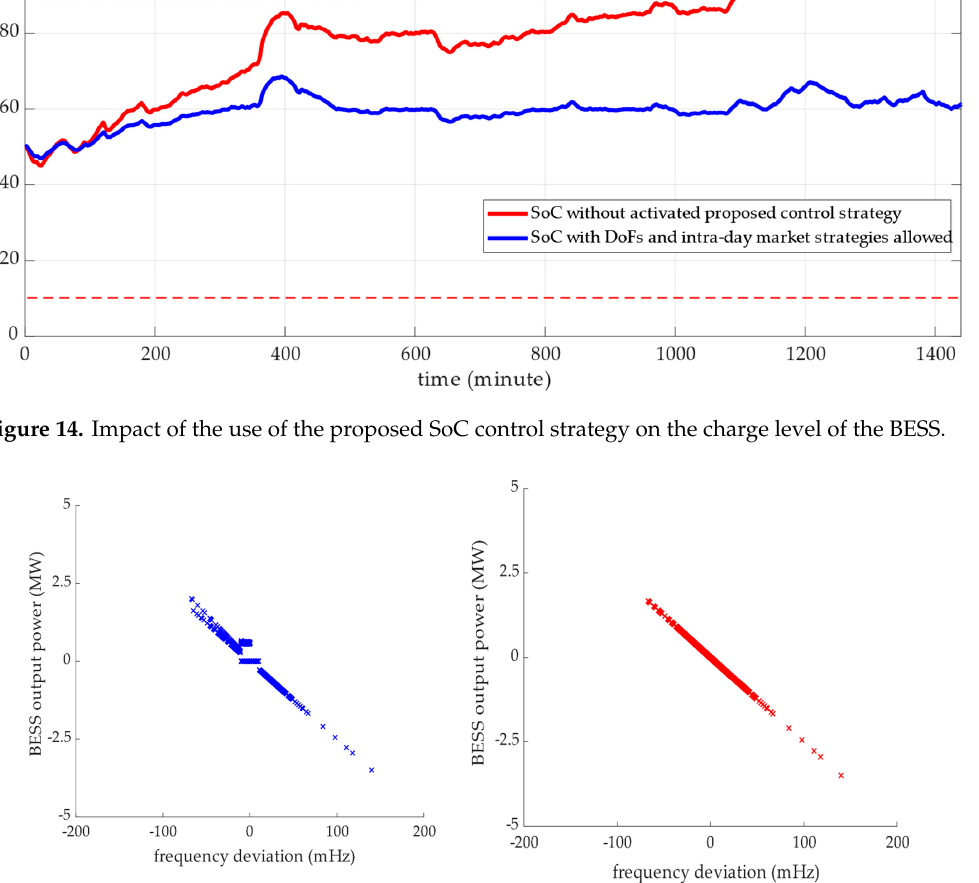
the day of maximum positive frequency deviation ( Δ f ) when all DoF strategies are in usage. ( b )